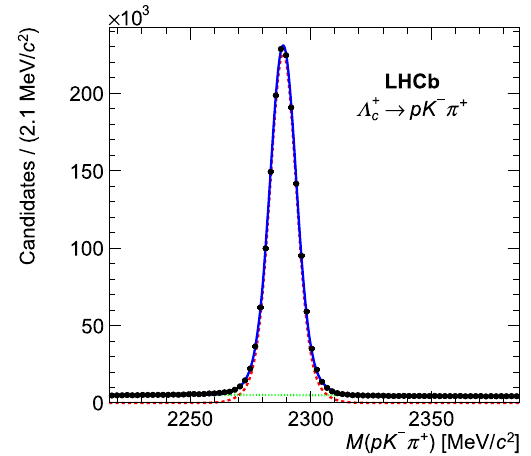
Fig. 1 Invariant-mass, M ( pK − π + ) , distributions of selected Λ + c can- didates are shown in the (left) 2011 and (right) 2012 data samples. Data points are in black. The overlaid fitted model (blue continuous line) is a